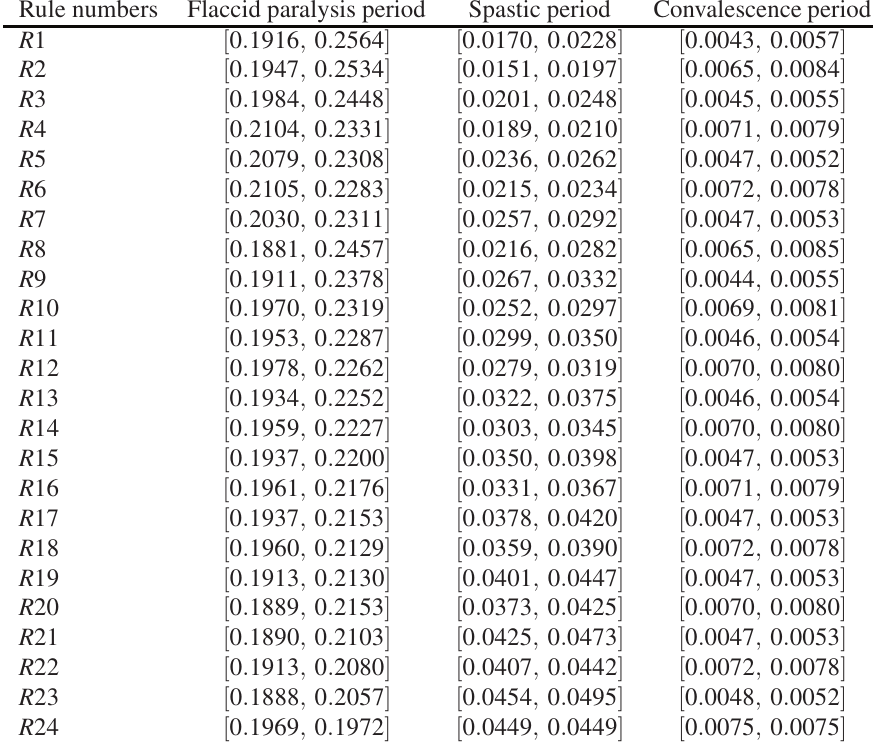
Table 3. The updated belief degree of consequent assessment.